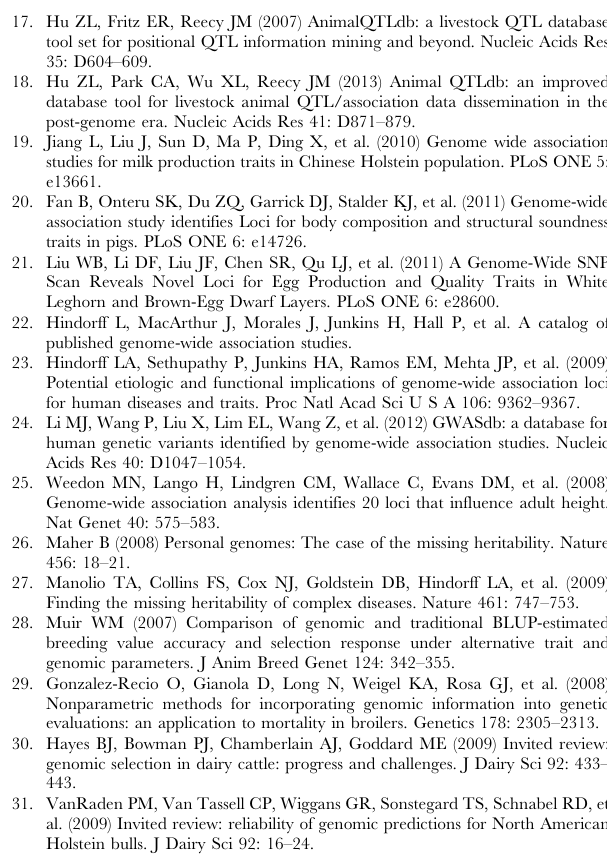
Figure S1 Computing times for GBLUP, BLUP|GA and BayesB. Computing times for GBLUP, BLUP|GA and BayesB (10,000 iterations) for population size N = 2,000 and m = 42,551 markers on an Intel Core i5-3470 CPU 3.2 GHz 6 4 with 16 GB RAM. For GBLUP and BLUP|GA, the computing time includes building the G matrix and solving the mixed model equations. For BayesB, the average time demanding for 10,000 iterations is shown. Figure S2 Estimated marker effects for milk yield in dairy cattle. Estimated marker effects obtained with different population sizes ( N ). Dark blue dots represent the top 1% SNPs with the largest estimated marker effects. Figure S3 Distribution of reported QTLs positions and marker weights obtained from rice QTL list. Reported QTLs associated with plant height (red), and panicle lenght (blue) retrieved from Gramene database (ftp://ftp.gramene.org/pub/